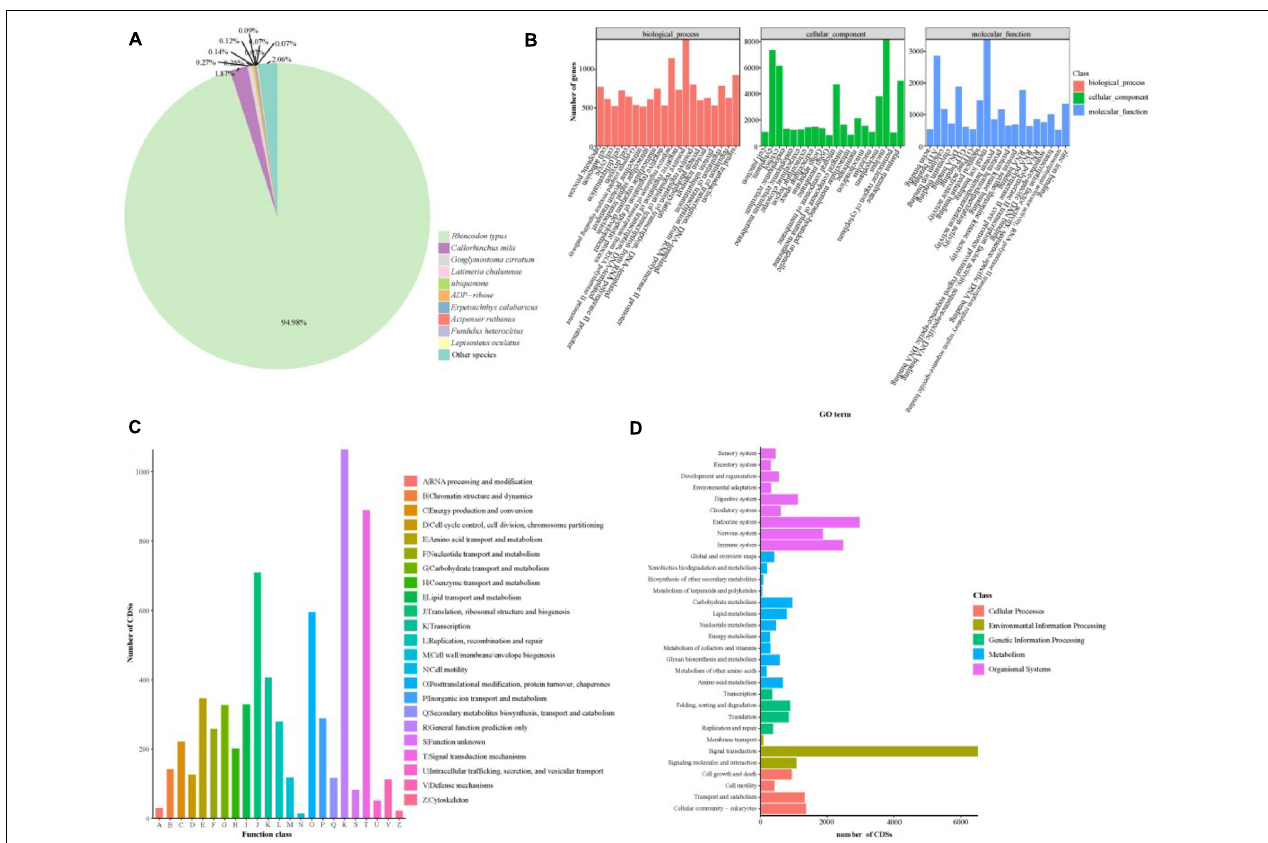
FIGURE 9 | CDSs annotation information in Nr (A) , GO (B) , COG (C) , and KEGG (D) database.